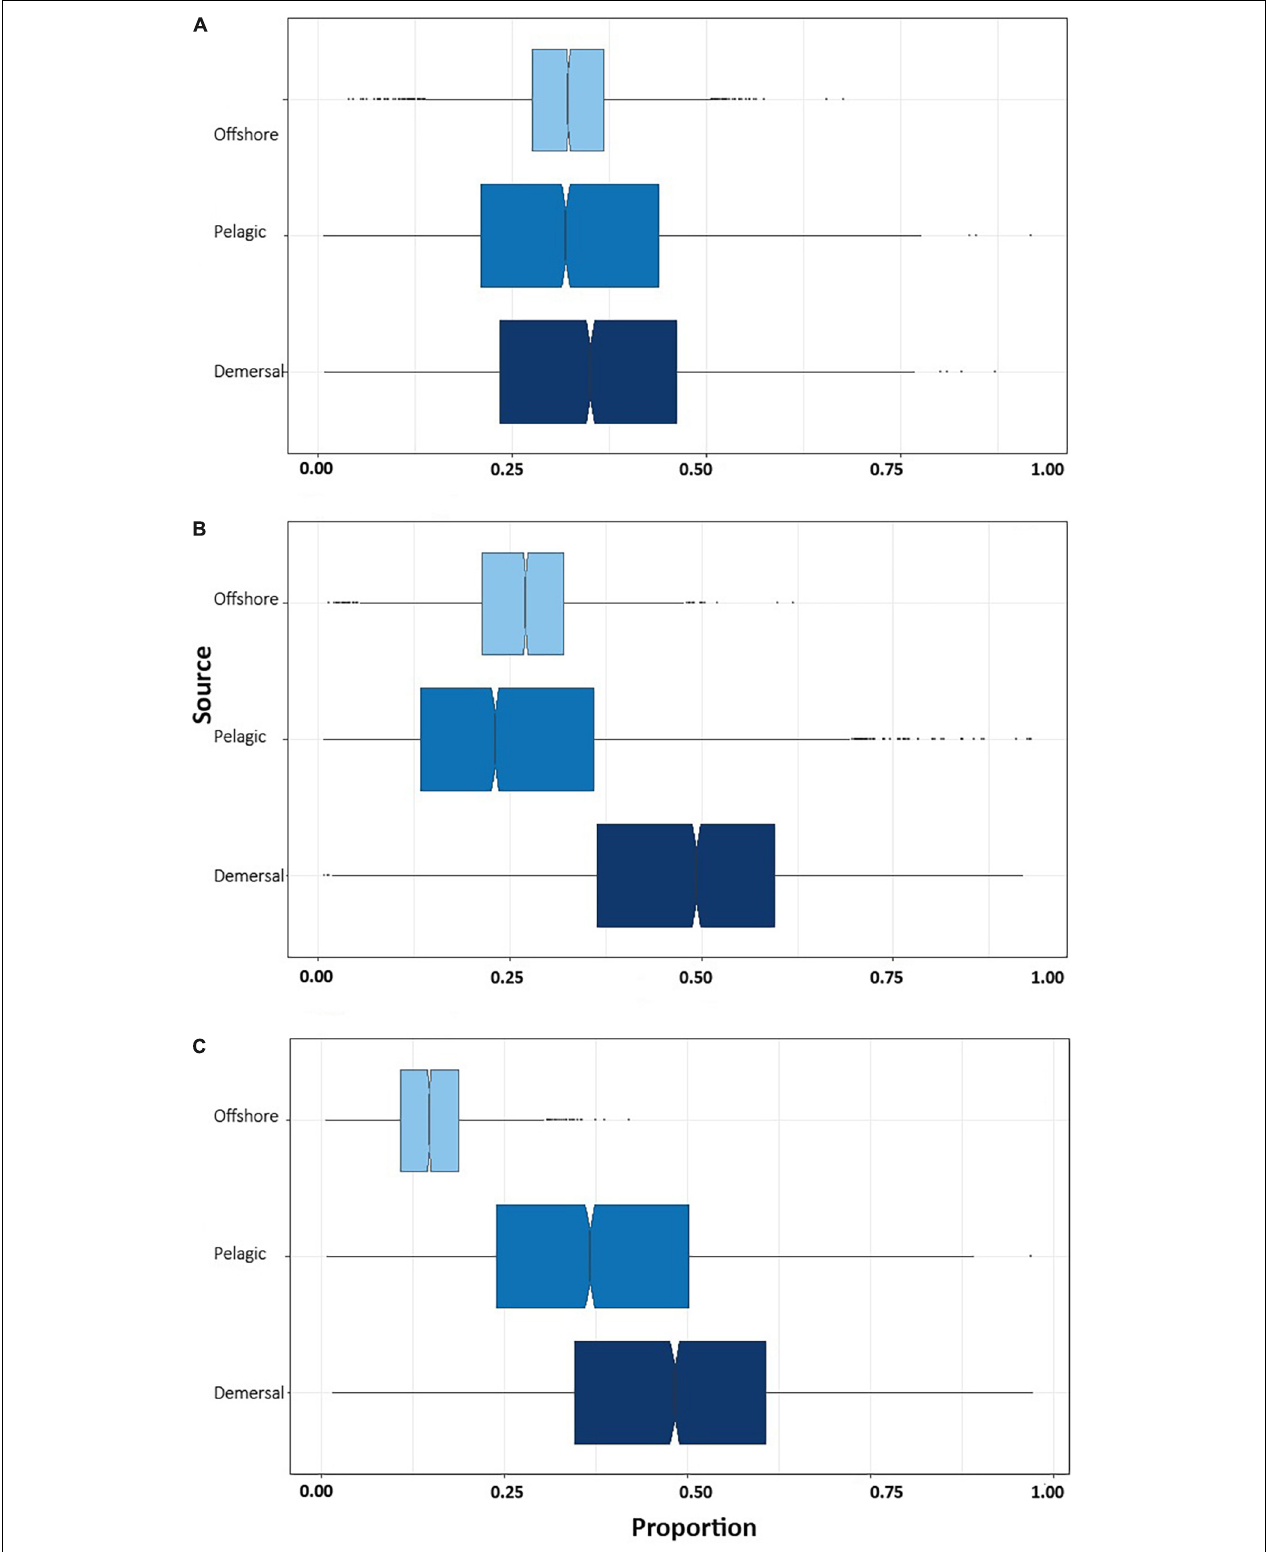
FIGURE 3 | Contribution of prey from different habitats to the isotopic composition of the muscle tissue of immature white sharks sampled in Bahía Sebastián Vizcaíno. (A) Newborn, (B) young of the year (C) juvenile white sharks.